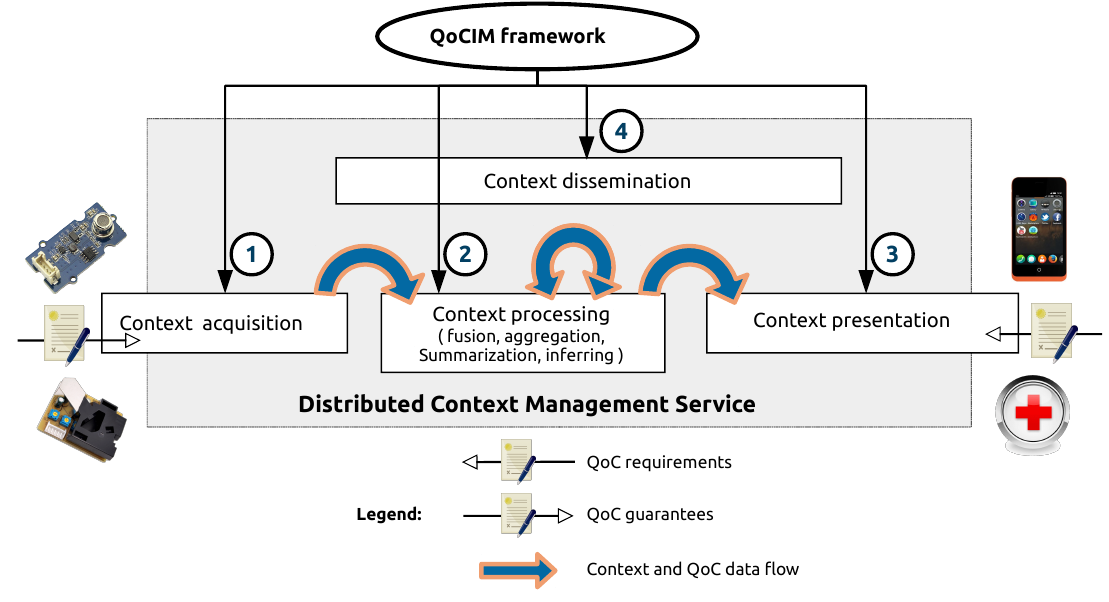
Figure 5. The four points where the QoCIM framework